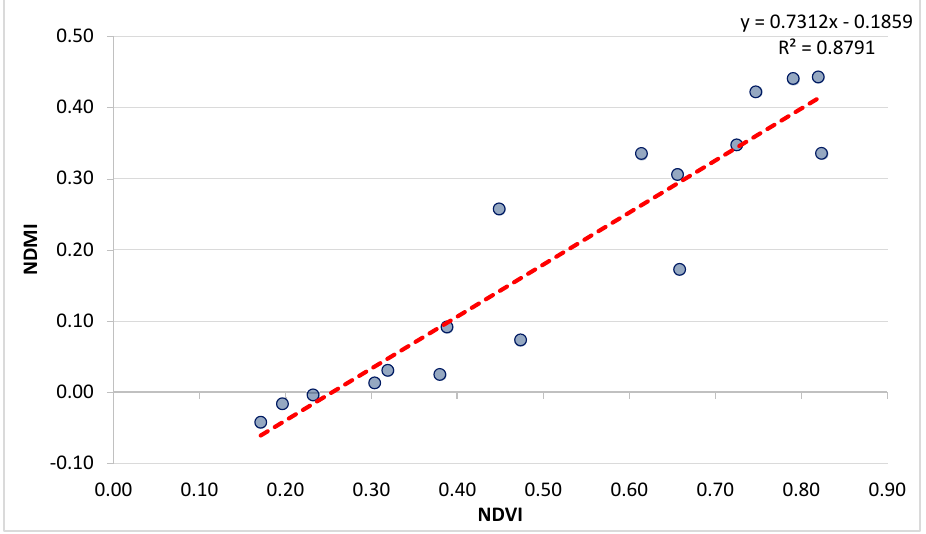
Figure 13. NDMI Correlation with NDVI-wheat in 143 Center pivot wheat field products with a 5-day temporal resolution.